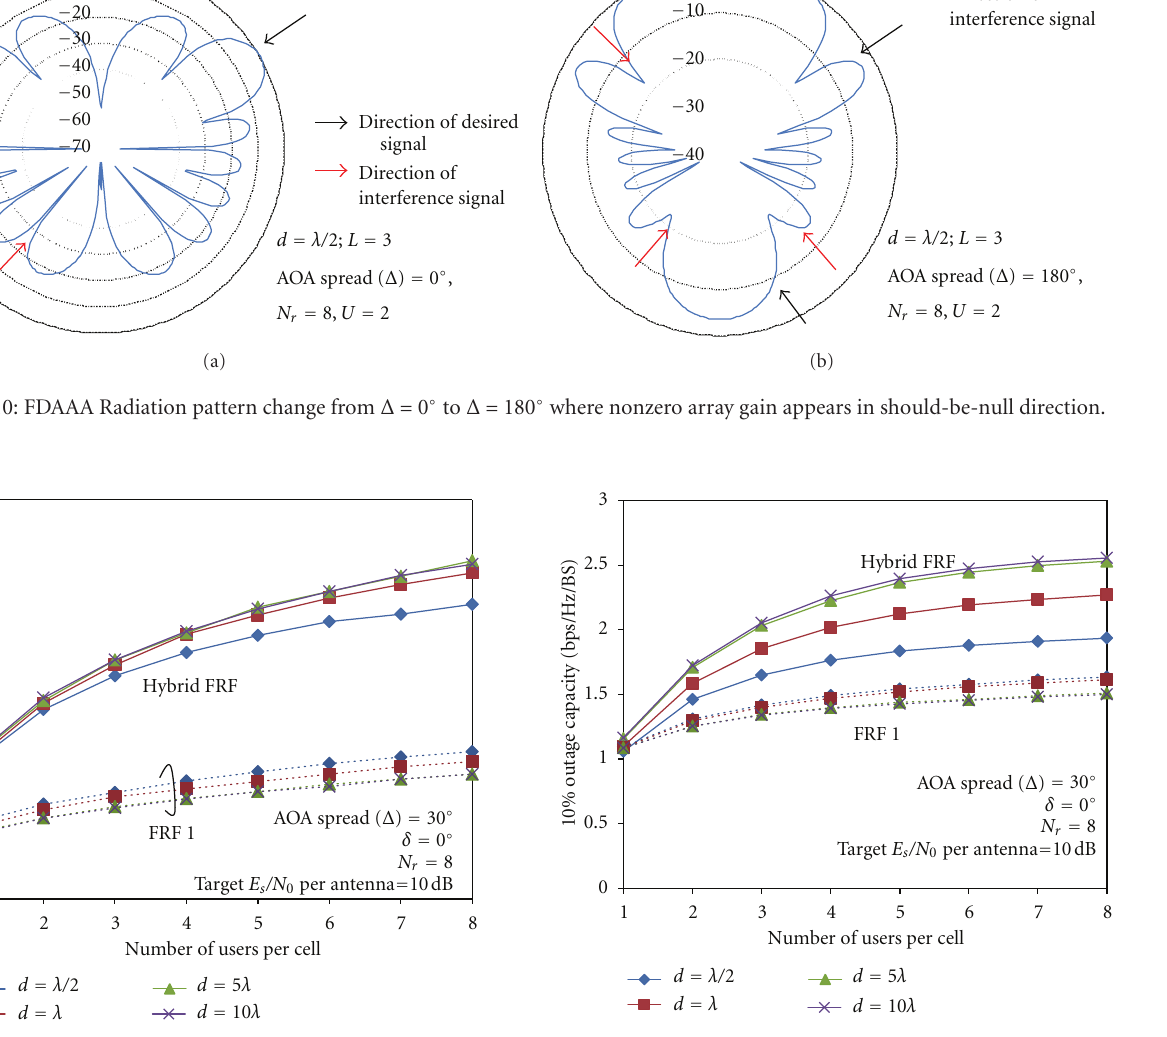
Figure 12: Cellular outage capacity with outage probability of